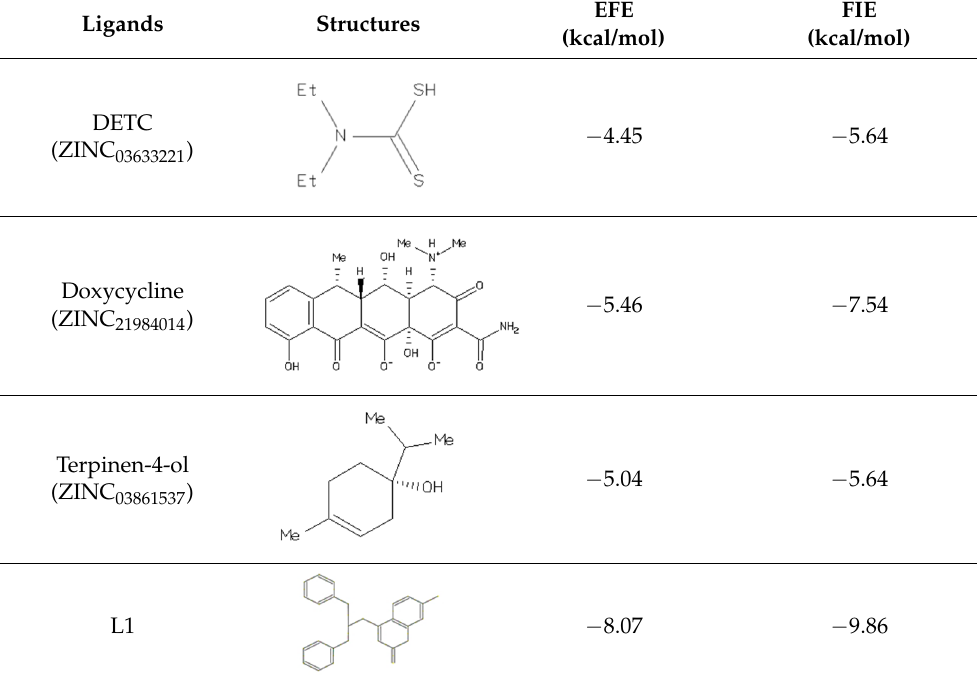
Figure 1. Active site of the Leishmania major glycoprotein of 63 kDa (gp63) in complex with diethyldithiocarbamate (DETC);